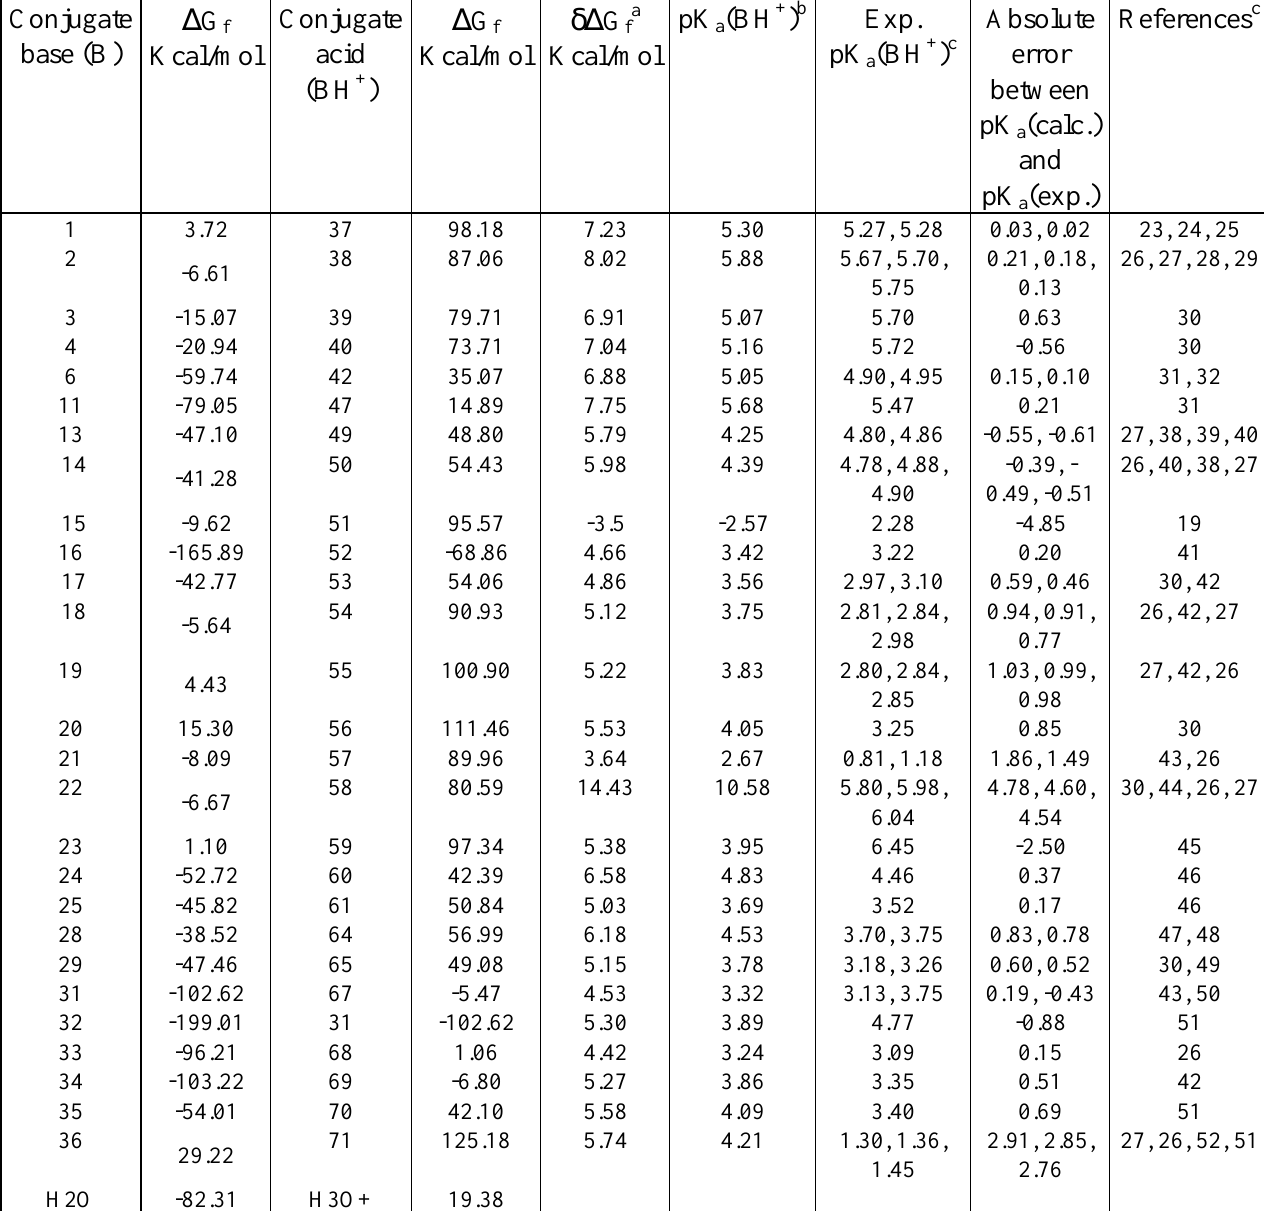
Table 3. The AM1 calculated pK